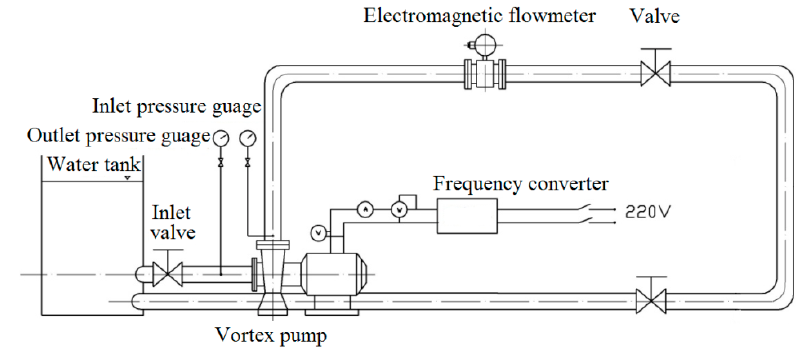
Figure 2. Scheme of the experimental test bench. Table 2. The technical data for instrumentation.